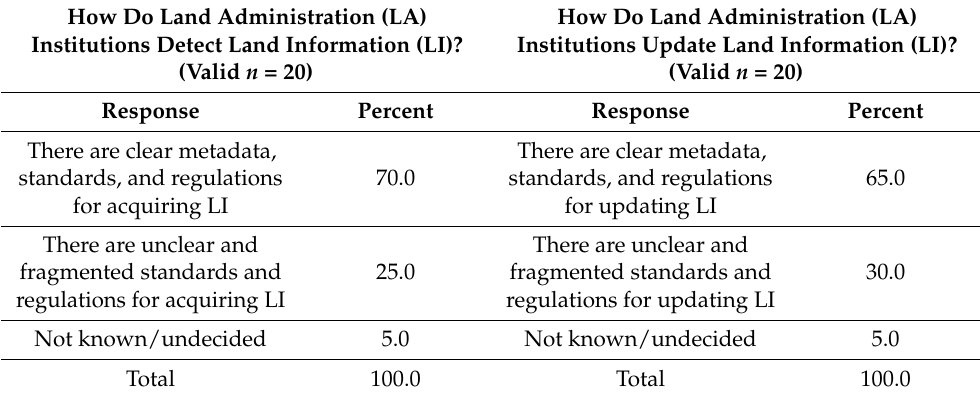
Table 2. Responses of LI experts on the availability of clear standards for detecting and updating